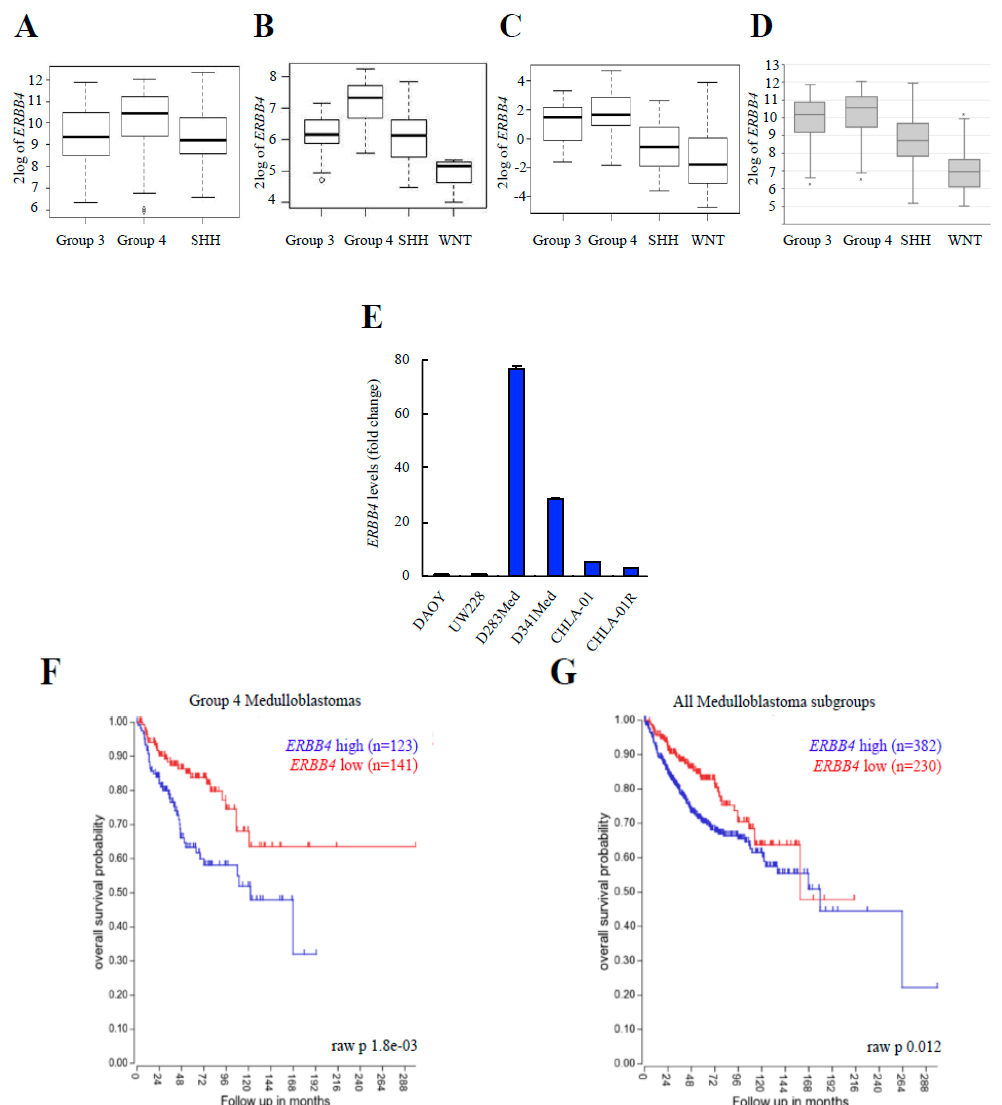
Figure 3. High levels of ERBB4 are found in Group 4 medulloblastomas and are associated with poor clinical outcome. ( A – D ) Boxplot of the log2 of ERBB4 expression in the indicated medulloblastoma subgroups in ( A ) Northcott et al. (2012) cohort ( n = 1087), ( B ) Robinson et al. (2012) cohort ( n = 76), ( C ) Remke et al. (2011) cohort ( n = 64), and ( D ) Cavalli et al. (2017) cohort ( n = 612). ( E ) ERBB4 mRNA expression in the indicated medulloblastoma cell lines ( n ≥ 3). ( F , G ) Kaplan–Meier curves for the Cavalli et al. (2017) cohort’s Group 4 patients’ and all patients’ overall survival rates based on ERBB4 expression obtained from hgserver1.